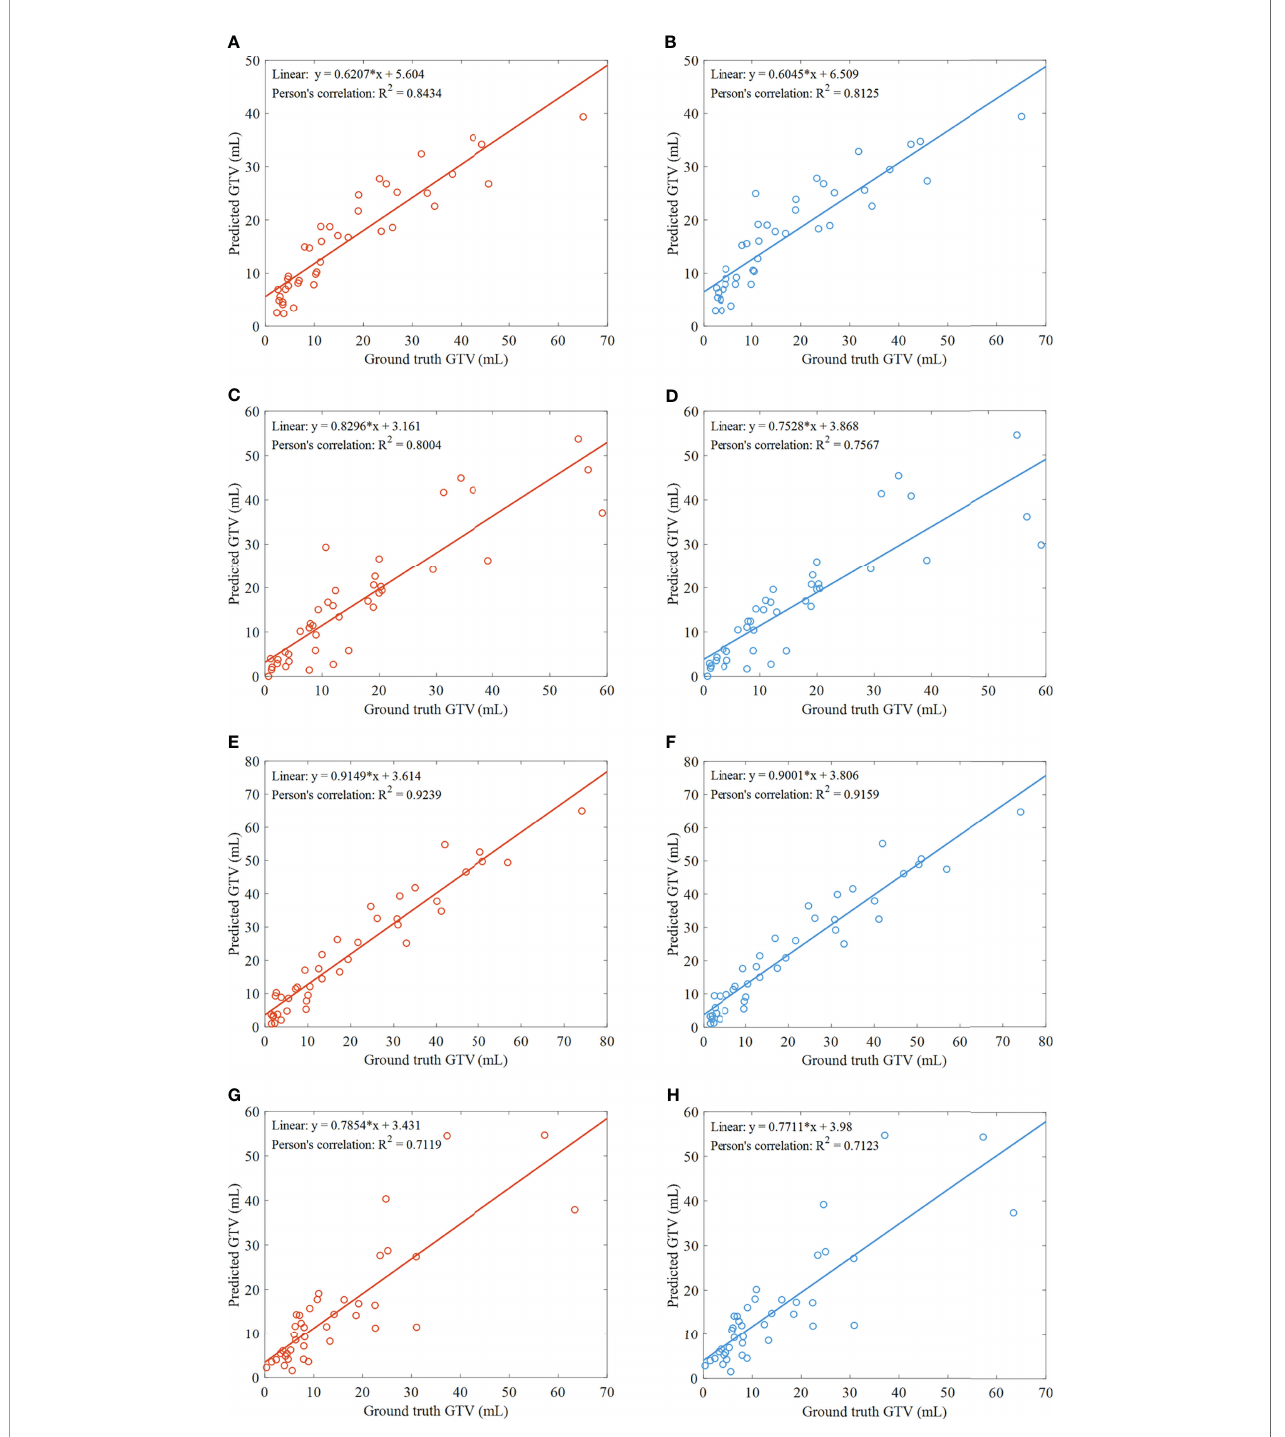
FIGURE 5 | Results of GTV assessment. (A) Scatter plot and correlation between the predicted GTVs by ETECIM and manual ground truth GTVs, for the fi rst fold cross-validation. (B) Scatter plot and correlation between the predicted GTVs by voxel summation method and manual ground truth GTVs, for the fi rst fold cross- validation. For the same reason, (C, D) are results for the second fold cross-validation. (E, F) are results for the third fold cross-validation. (G, H) are results for the fourth fold